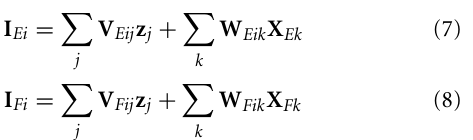
FIGURE 1 | Schematic illustration of the three-level central pattern generator (CPG) concept:The locomotor CPG consists of a half-center rhythm generator (RG), a pattern formation (PF) network and a motorneuron layer. Rhythmic generator layer (yellow area): this layer contains oscillators which generate rhythmic signals as the input to the PF layer. PF layer (red area: only three neurons are drawn with others neglected):The PF network contains interneuron populations, each of which provides excitation to multiple synergistic